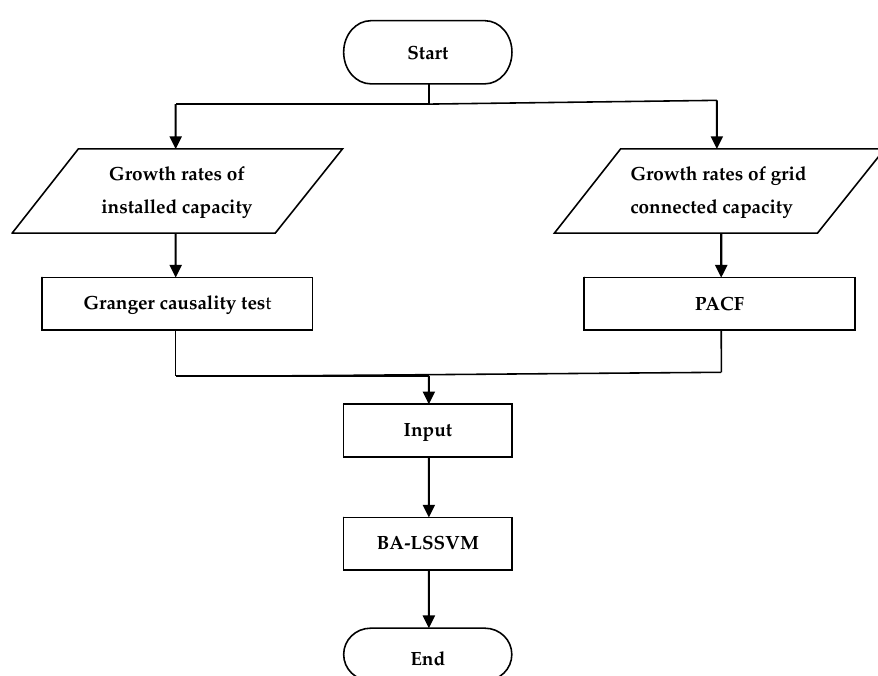
Figure 5. The overall forecasting method of BA ‐ LSSVM.